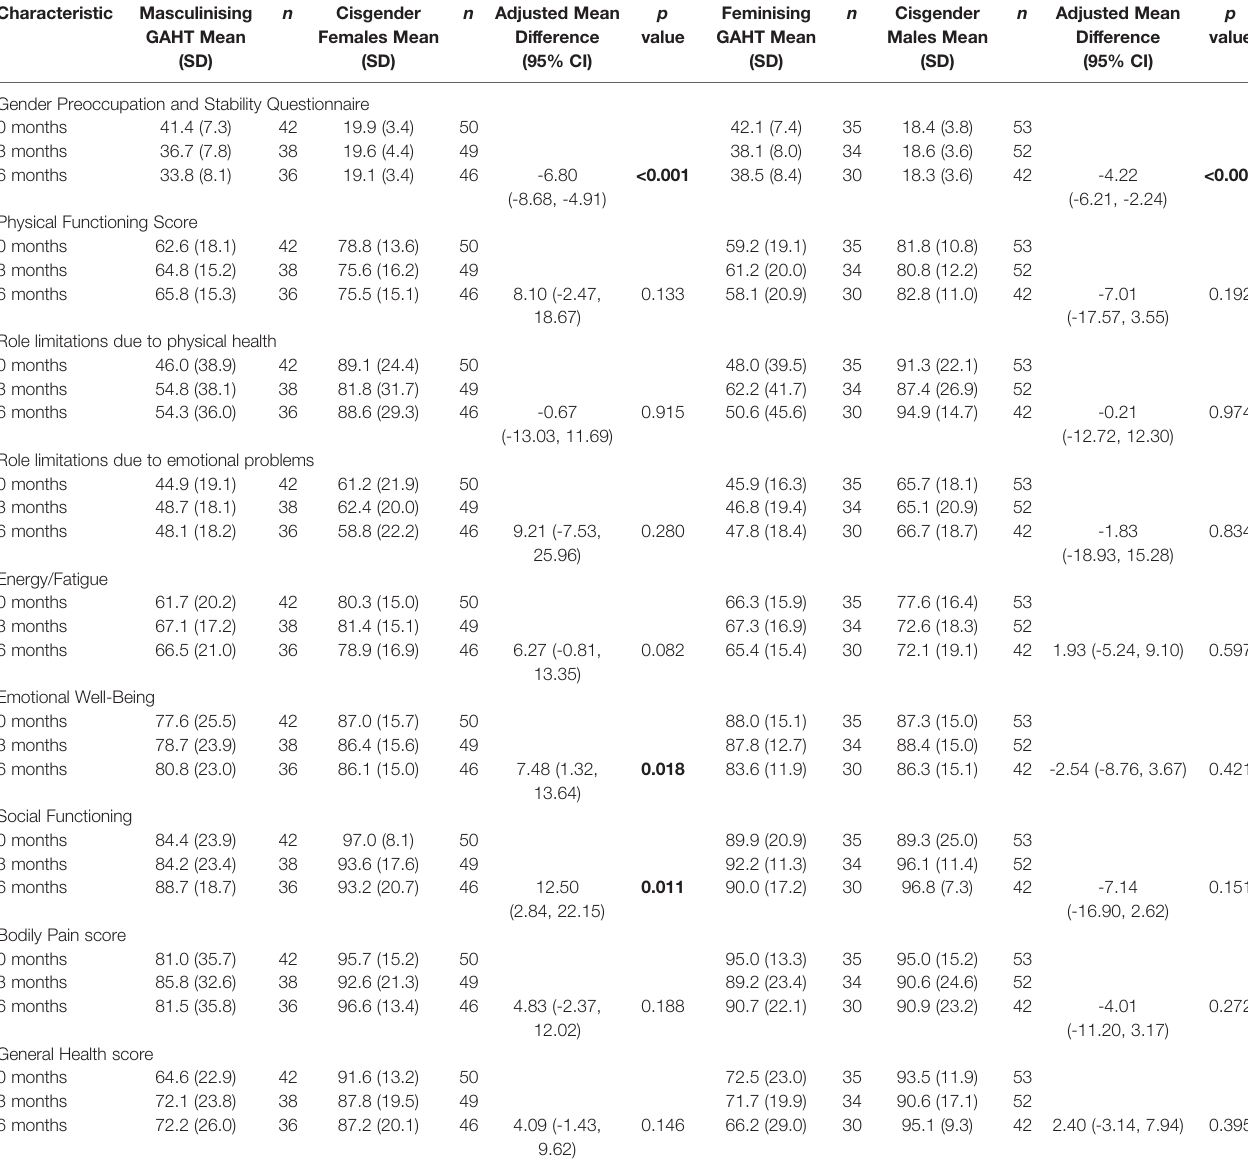
TABLE 2 | Overall mean differences in GPSQ and QoL scores between the trans participants and cisgender comparison groups adjusted for age. Characteristic Masculinising GAHT